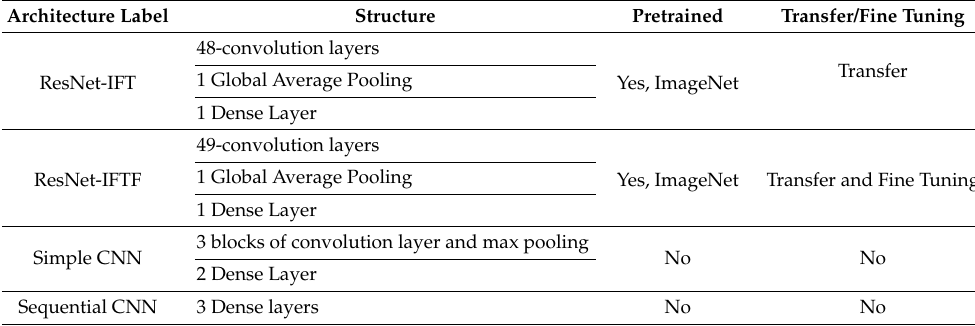
Table 2. Summary of CNN Architectures tested.